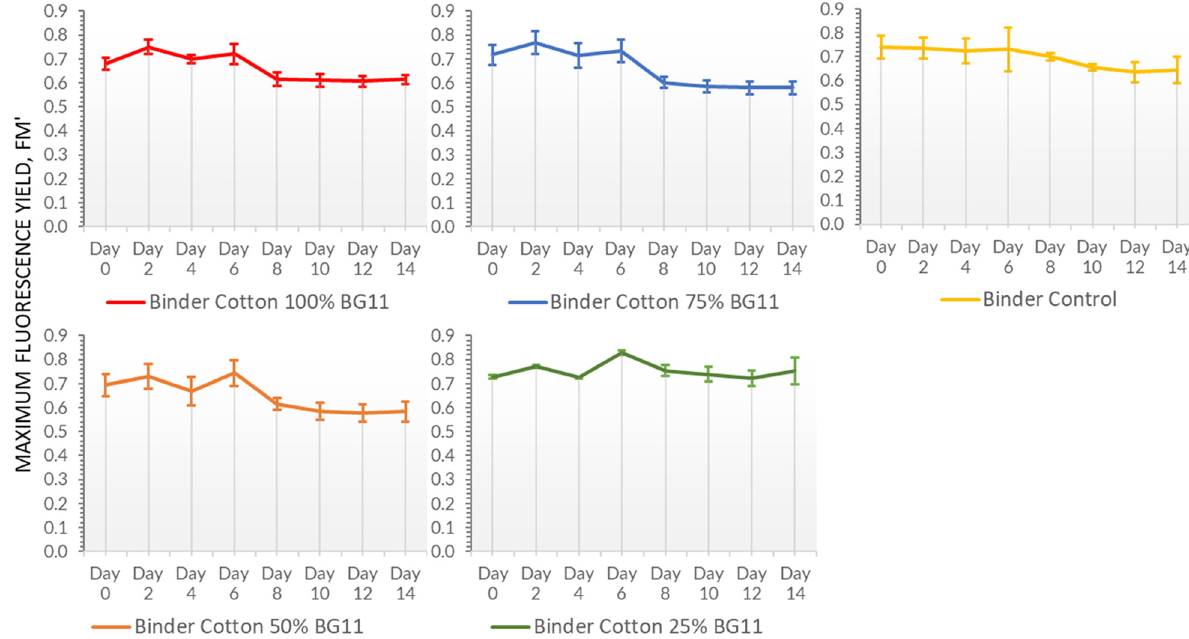
Figure 5: Closed incubation of 20% w/w binder on cotton with various nutrient media dilutions: 100% BG11 ( mean StDev = 0.027 ) , 75% BG11 ( mean StDev = 0.036 ) , 50% BG11 ( mean StDev = 0.044 ) , 25% BG11 ( mean StDev = 0.020 ) .